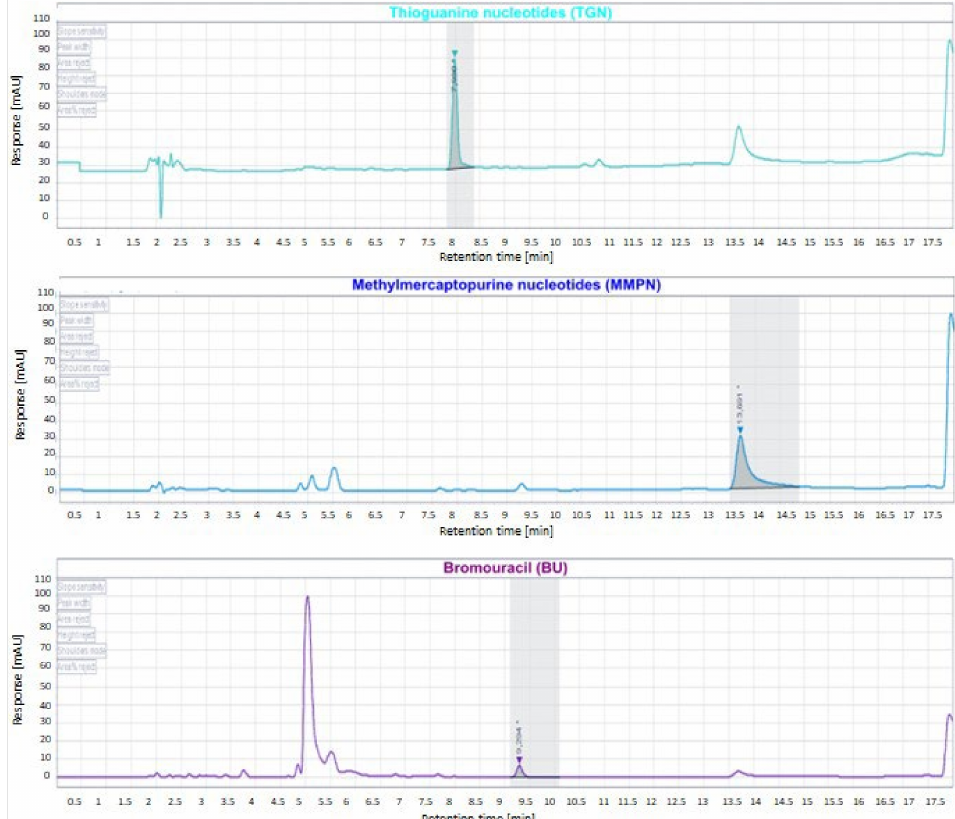
Figure 4. Chromatogram derived from the injection of a real sample containing TGN and MMPN (517.94 and 12,255.06 pmol/8 × 10 8 RBC, respectively). * indicates the retention